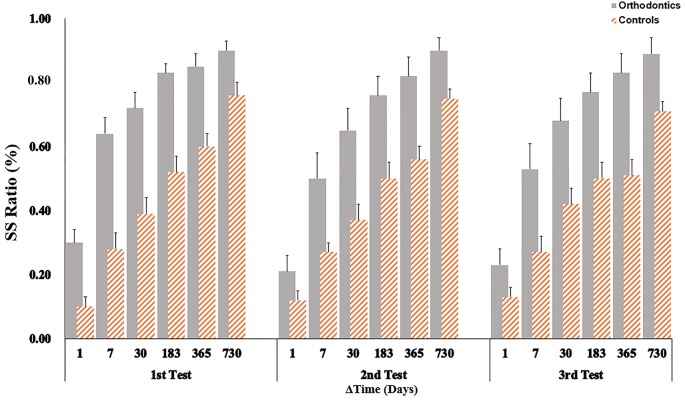
Performance as function of Δ Time. The percentage of SS choices were shown for six different time intervals. Orthodontic patients were biased to choose SS options in each waiting time condition for each section. Error bars showed one standard error.